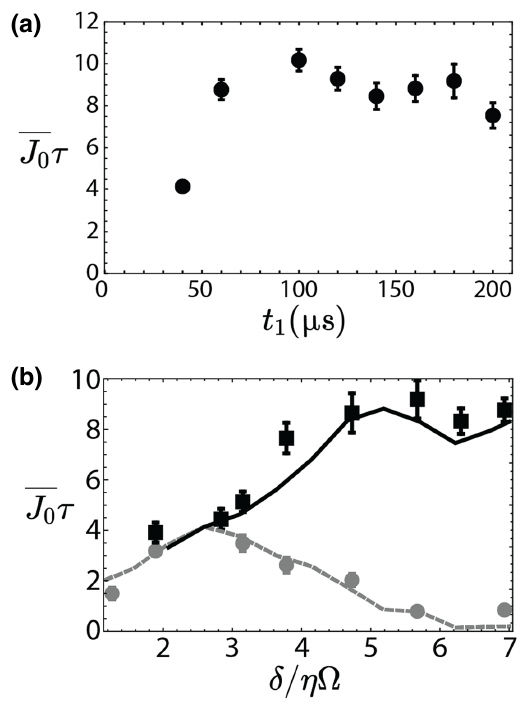
FIG. 3. The dependence of dynamical decoupling on pulse parameters. (a) The dependence of dynamical decoupling on the pulse length t 1 . The scaled coherence time J 0 τ is largely flat for pulses longer than 50 µ s, suggesting that the noise is slow enough to be largely canceled out for any choice within this range. For these data, the detuning is fixed at δ/η(cid:6) = 4.1. For sufficiently fast drives, we see a decrease in J 0 τ , which is caused by a decreasing J 0 without any compensating improvement in τ on detuning δ , for both decoupled τ . (b) The dependence of J 0 (black) and regular (gray) sequences. The points are experimen- tal data, while the solid lines are numerics incorporating the dominant noise sources (see Appendix A 5). Decoupling is most effective in the regime of large detuning, δ/η(cid:6) > 5, in which the evolution without decoupling is nearly completely destroyed. For these data, the drive is fixed at t 1 = 120 µ s, and pulse shap- ing is fixed at t p = 20 µ s throughout. The experimental data in both plots are averaged over 300 shots, with error bars from the fit